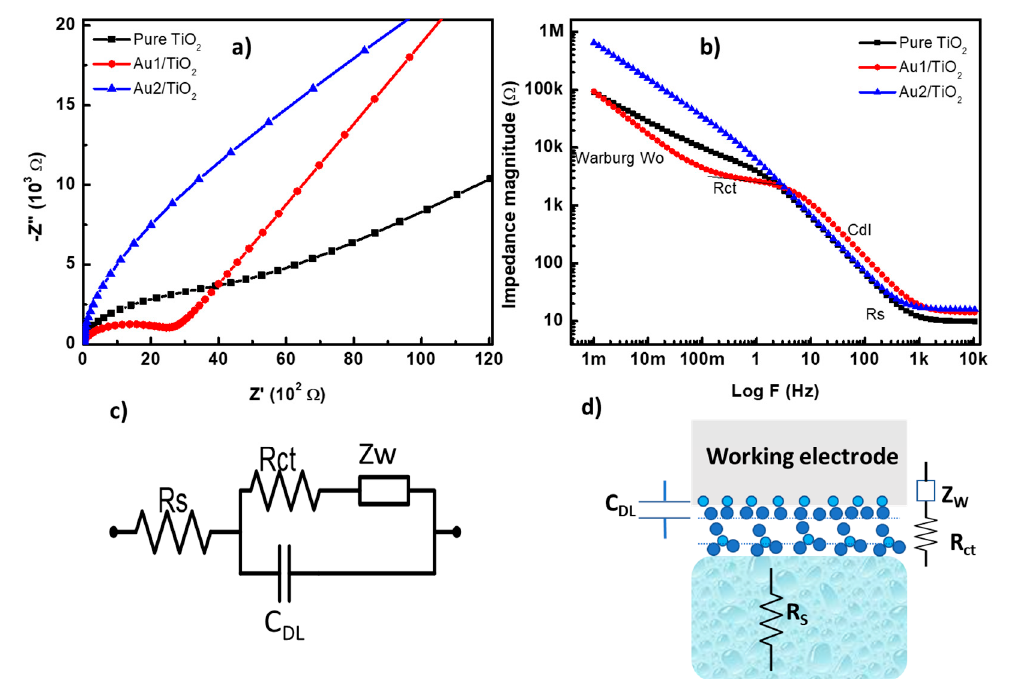
Figure 12. ( a ) Nyquist plot, ( b ) Bode plots of the impedance magnitude of an electrochemical interface, ( c ) the equivalent EIS proposed circuit (fitting by Zview software), and ( d ) scheme of the reaction that takes place at circuit components for pure TiO 2 , Au1/TiO 2 , and Au2/TiO 2 electrodes. Table 2. The values of solution resistance (Rs) and electron transfer resistance (Rct) for the tested devices.